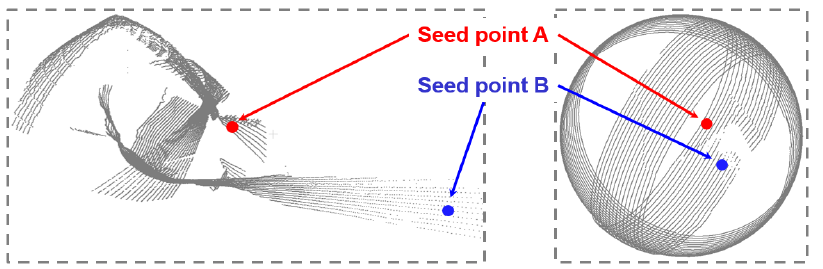
Figure 23. A LiDAR scan and two sample seed points; points are represented by Cartesian (left) and normalized polar (right) coordinates.